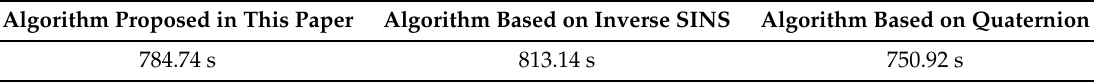
Table 1. The computation time of the three